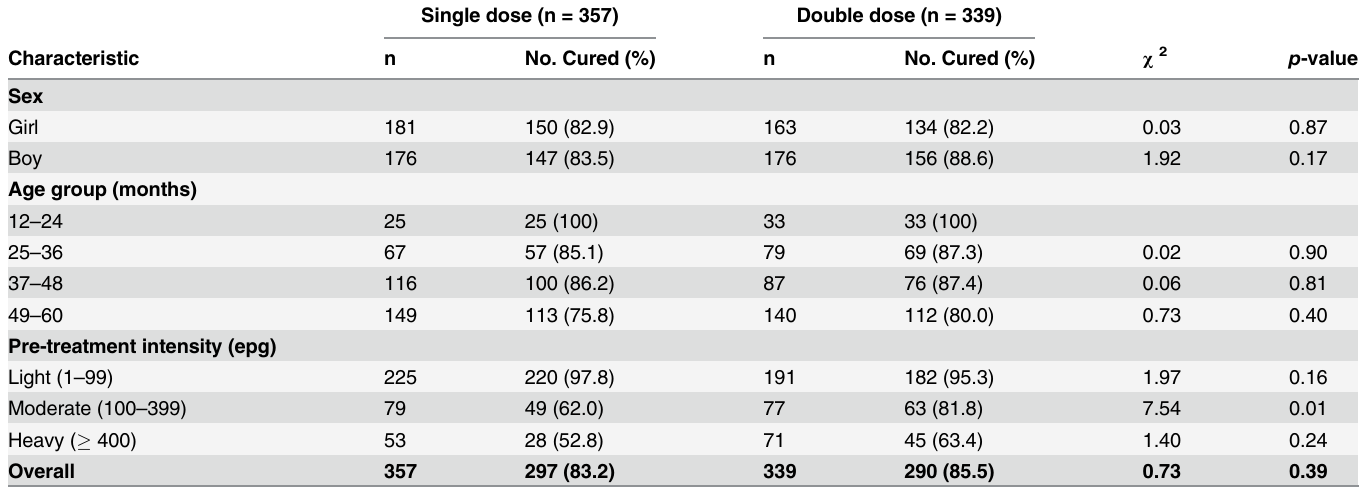
Table 3. Comparison of cure rates of praziquantel between single and double doses assessed 1-month post-treatment with regard to sex, age and S . mansoni infection intensity. Single dose (n = 357) Double dose (n = 339)